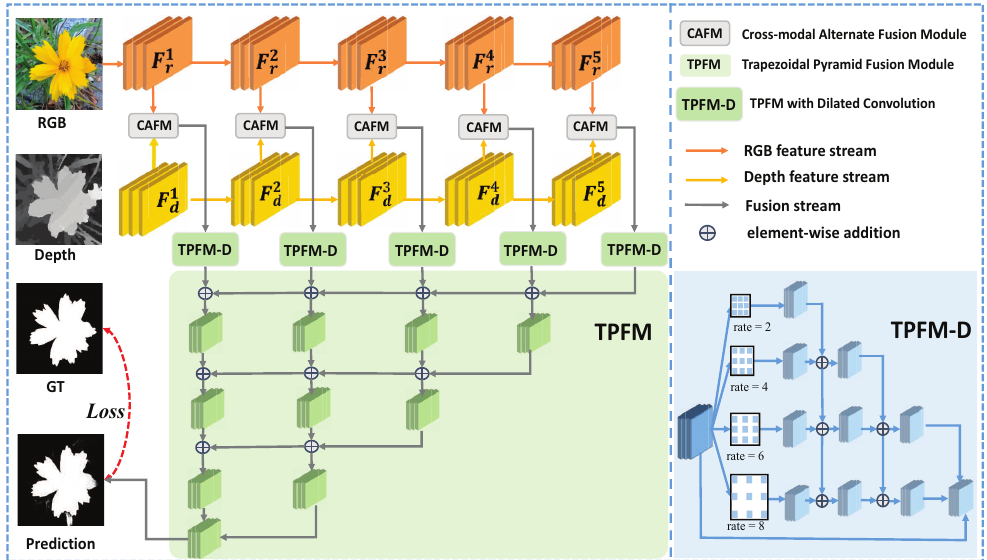
Figure 2. Pipeline of the proposed